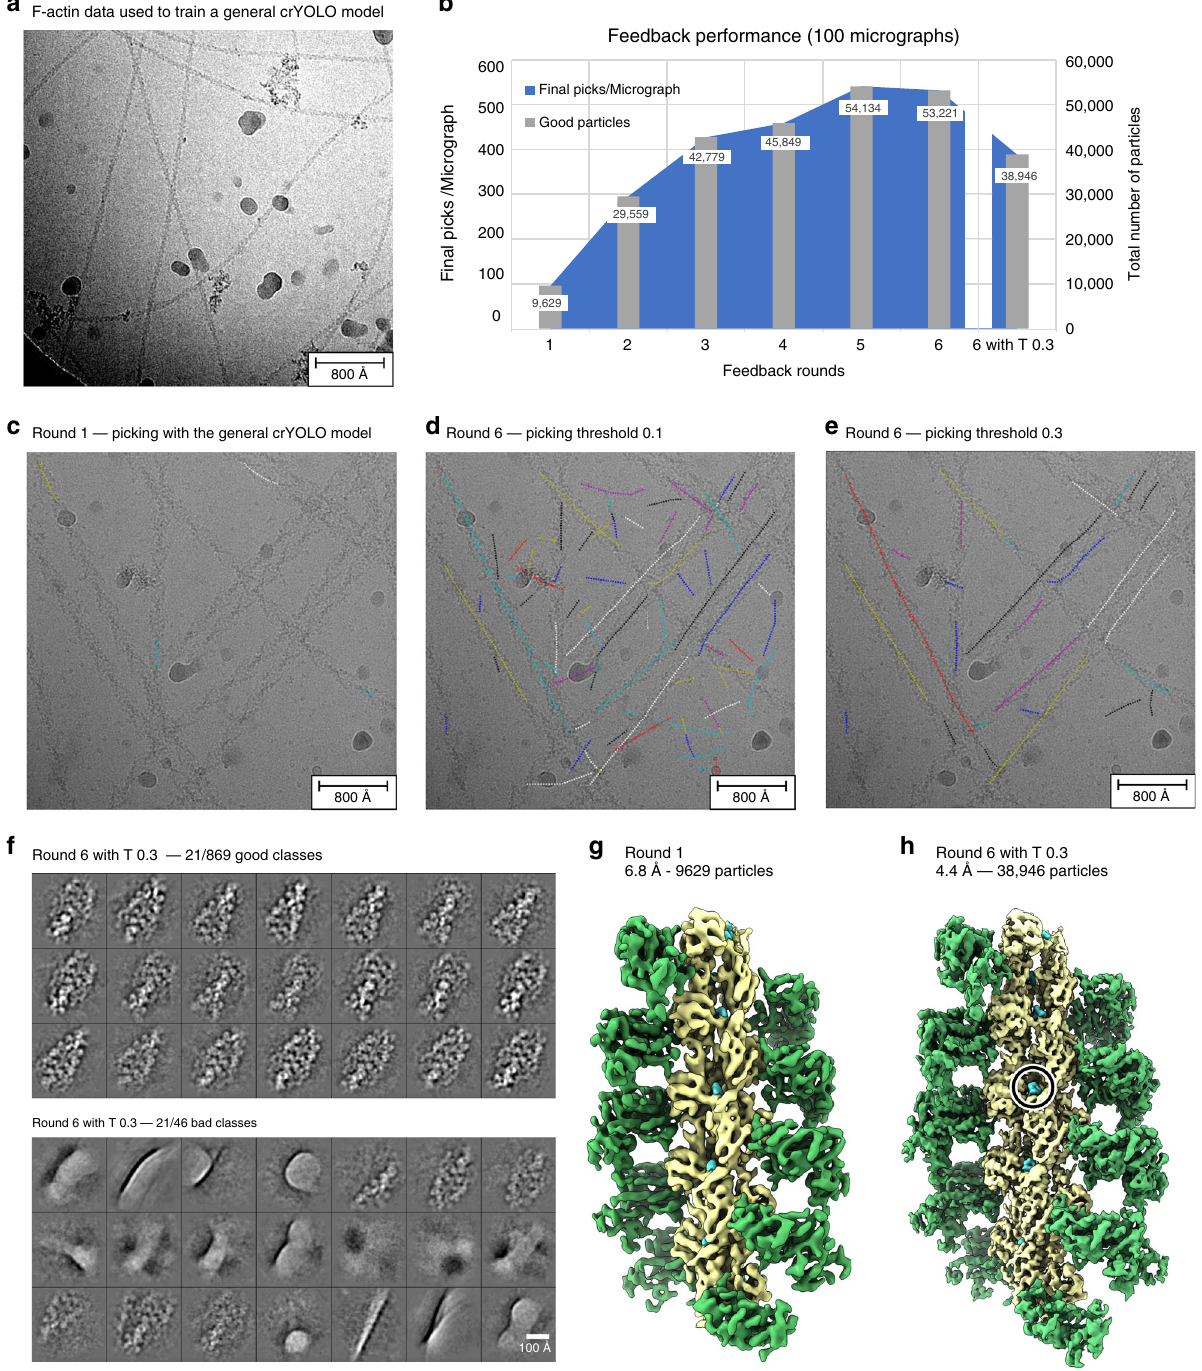
Fig. 5 Ligand identi fi cation within an actomyosin complex. a Representative micrograph of the F-actin data used to train crYOLO. b Progression of the number of “ good ” particles per micrograph (blue) and in total (gray) when applying the intermediate picking models of the feedback loop to a fi xed subset of 100 micrographs. The dipping curve at the end indicates the desired loss of low-quality picks that are excluded when a higher picking threshold (0.3) is used. c Representative micrograph of the actomyosin complex highlighting the weak initial picking results when using the crYOLO model trained on F-actin data (see a ). d Particle picking performance on the same micrograph using the fi nal picking model. While fi laments are now traced much more effectively, the model also picks unwanted fi lament crossings and contamination. e Increasing the picking threshold from 0.1 to the default value of 0.3 minimizes the amount of false positive picks, while maintaining the desired fi lament traces. f Representative 2D class averages labeled “ good ” (top) and “ bad ” (bottom) by Cinderella based on 100 micrographs and using the fi nal model for picking. g 3D reconstruction of the actomyosin complex computed from 100 micrographs using the initial picking model. h 3D reconstruction computed from the same 100 micrographs using the fi nal optimized picking model. The resolution is suf fi cient to verify the binding of a ligand